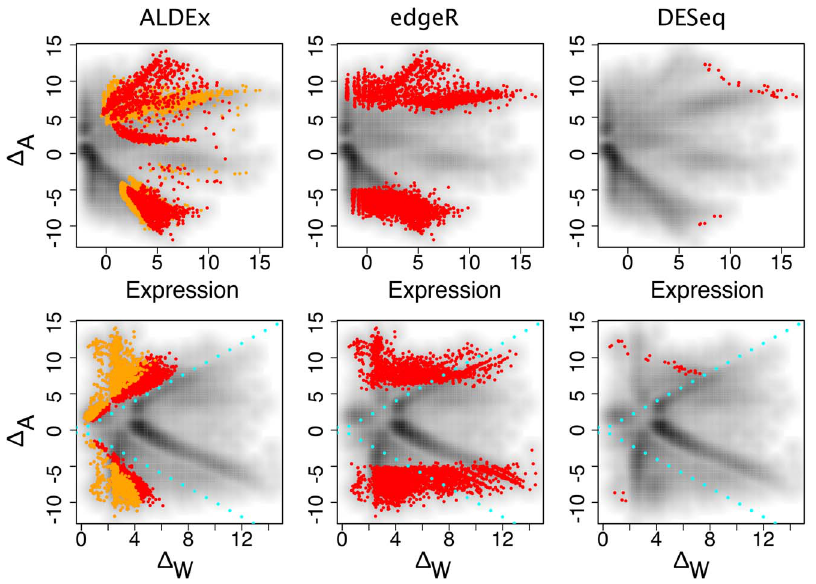
Figure 8. Comparison of three differential expression methods in the Meta dataset. This dataset contains extreme transcript abundance variation within- and between-conditions. In this dataset the ALDEx method exhibits similar characteristics as in the B. cereus dataset, in that it identifies as differential those transcripts that exhibit high between-condition variation and low within-condition variation. This is illustrated by the left column that shows an MA-like plot and an MW plot. It is obvious that the high levels of variation in the Meta dataset is a poor fit to the negative binomial model used by both edgeR and DESeq. The edgeR package appeared to enforce a relatively high between-condition differential expression level regardless of the mean expression value. This leads to many poorly expressed transcripts being identified as differentially expressed. In contrast, the DESeq package identified as differentially expressed a small number of highly expressed genes. As before, transcripts with differential abundances are coloured red (and orange) as per the rules outlined in Figure 5.